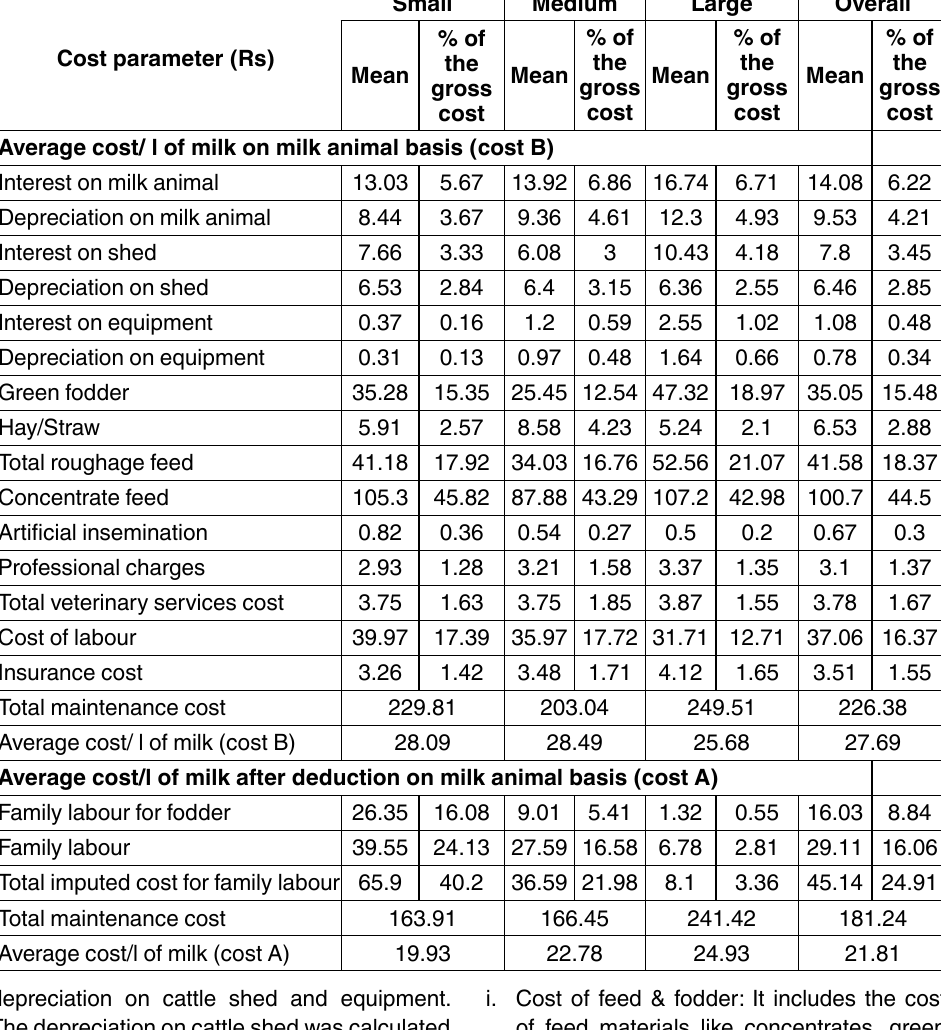
Table 1 . Cost of milk production per litre on milk animal basis in small, medium, large, and overall average value of all the